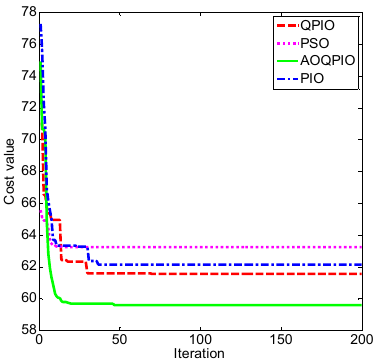
Figure 7. The comparative curves of iteration of the algorithms of the experiment carried out in map 2.